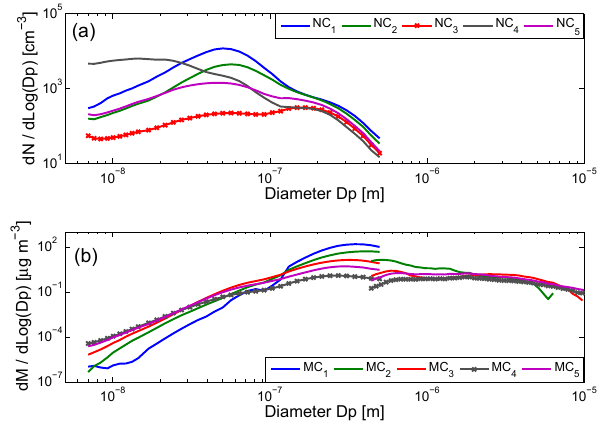
Figure 5. Average particle (a) number and (b) mass size distribu- tions for different clusters (nos. 1–5). Crosses mark the most com- mon cluster type found in both panel (a) and (b) . In panel (b) the APS mass size distributions (at > 410nm sizes) belonging to each of the clusters are also presented for times when they are